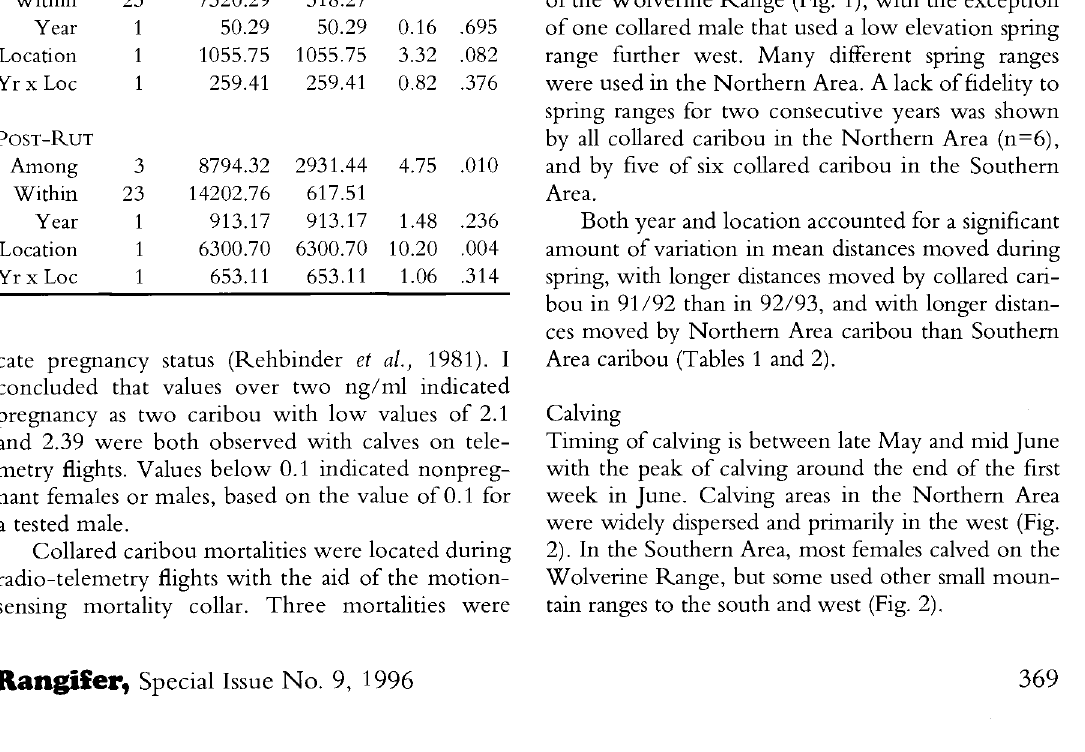
Table 2. The effects of year (91/92, 92/93) and location (Northern Area, Southern Area) on mean migration distances of collared females during spring, pre-rut and post-rut